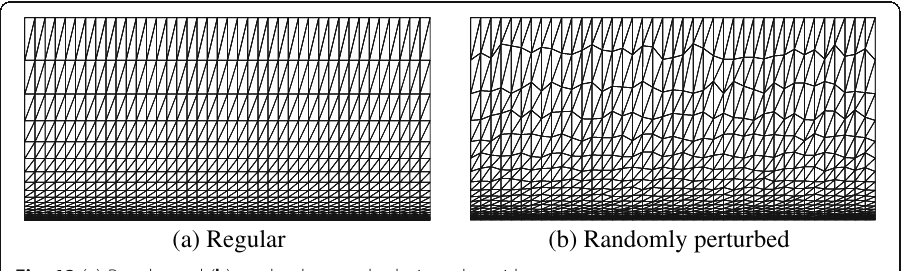
Fig. 12 ( a ) Regular and ( b ) randomly perturbed triangular